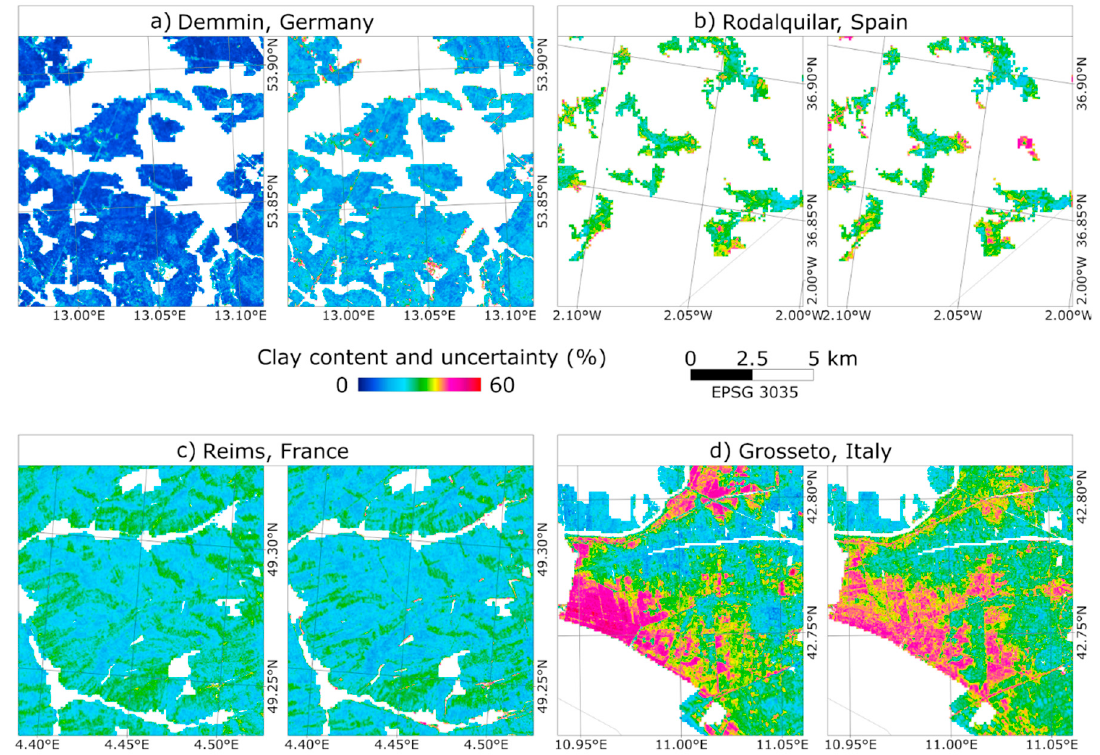
Figure 5. ( a ) Regional clay map (left) and uncertainty (right) near Demmin, Germany; ( b ) regional clay Figure 5. a) Regional clay map (left) and uncertainty (right) near Demmin, Germany; b) regional clay map (left) and uncertainty (right) near Rodalquilar, Spain; ( c ) regional clay map (left) and uncertainty map (left) and uncertainty (right) near Rodalquilar, Spain; c) regional clay map (left) and uncertainty (right) near Reims, France; ( d ) regional clay map (left) and uncertainty (right) near Grosseto, Italy. Note: (right) near Reims, France; d) regional clay map (left) and uncertainty (right) near Grosseto, Italy. the regional maps were masked by croplands of the CORINE 2012 Note: the regional maps were masked by croplands of the CORINE 2012 map.